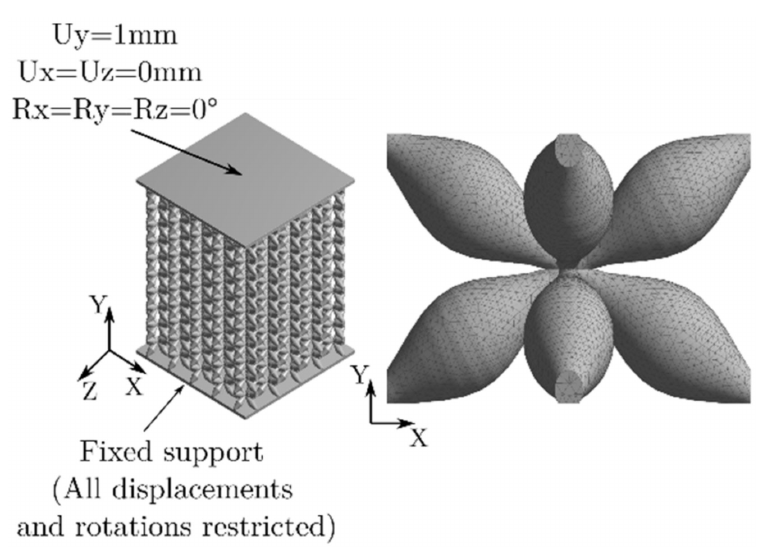
Figure 6. Left: Boundary conditions for FEA simulation. Right: Unit cell showing mesh size